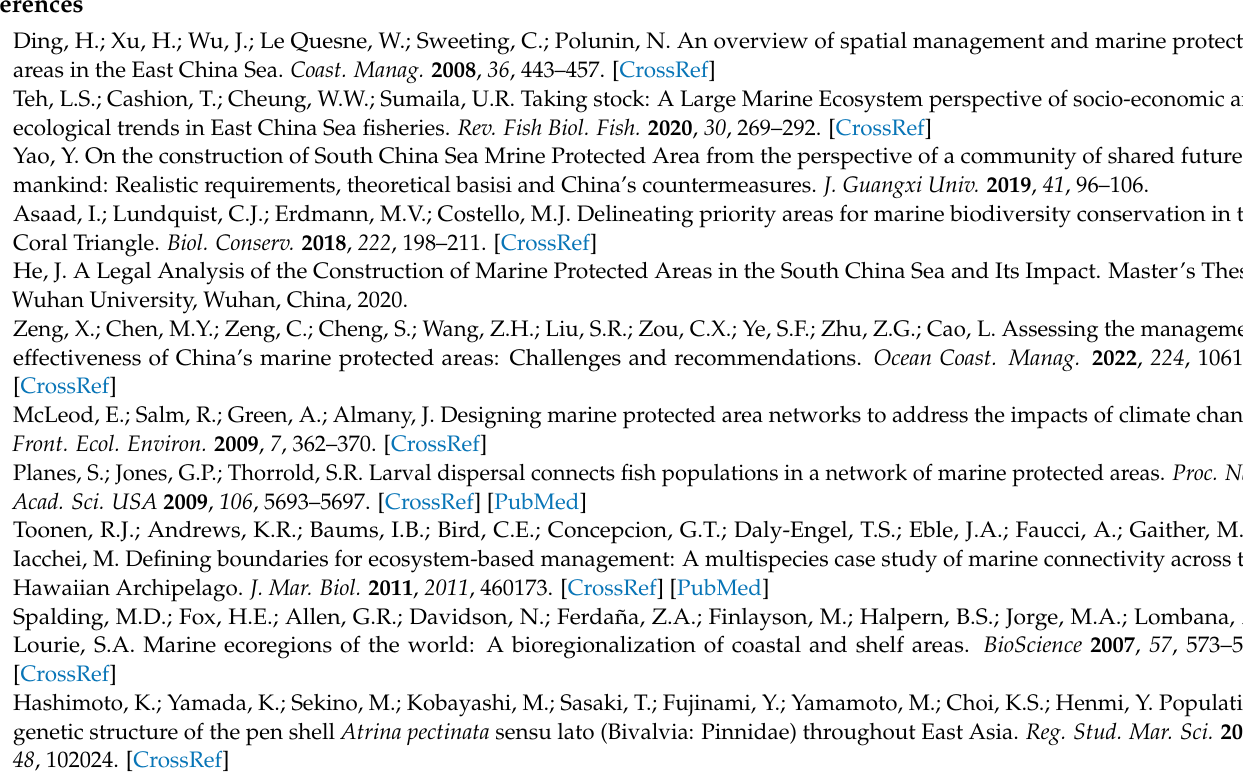
Table S5: The effective population sizes for each population based on COI and D-Loop sequences; Figure S1: The minimum spanning network based on COI sequences; Figure S2: The minimum spanning network based on D-Loop